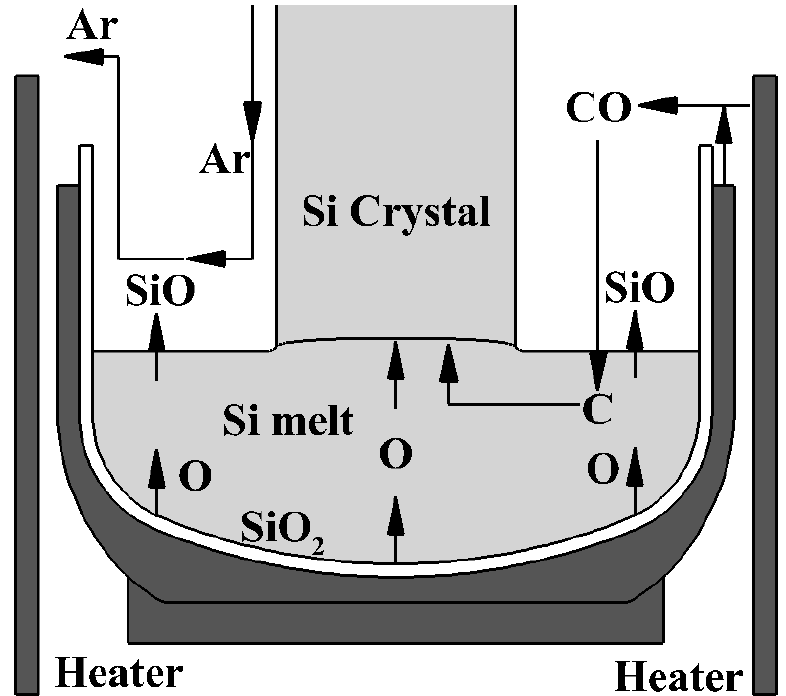
Figure 1. Schematic diagram of SiO and CO transfer in a CZ furnace.